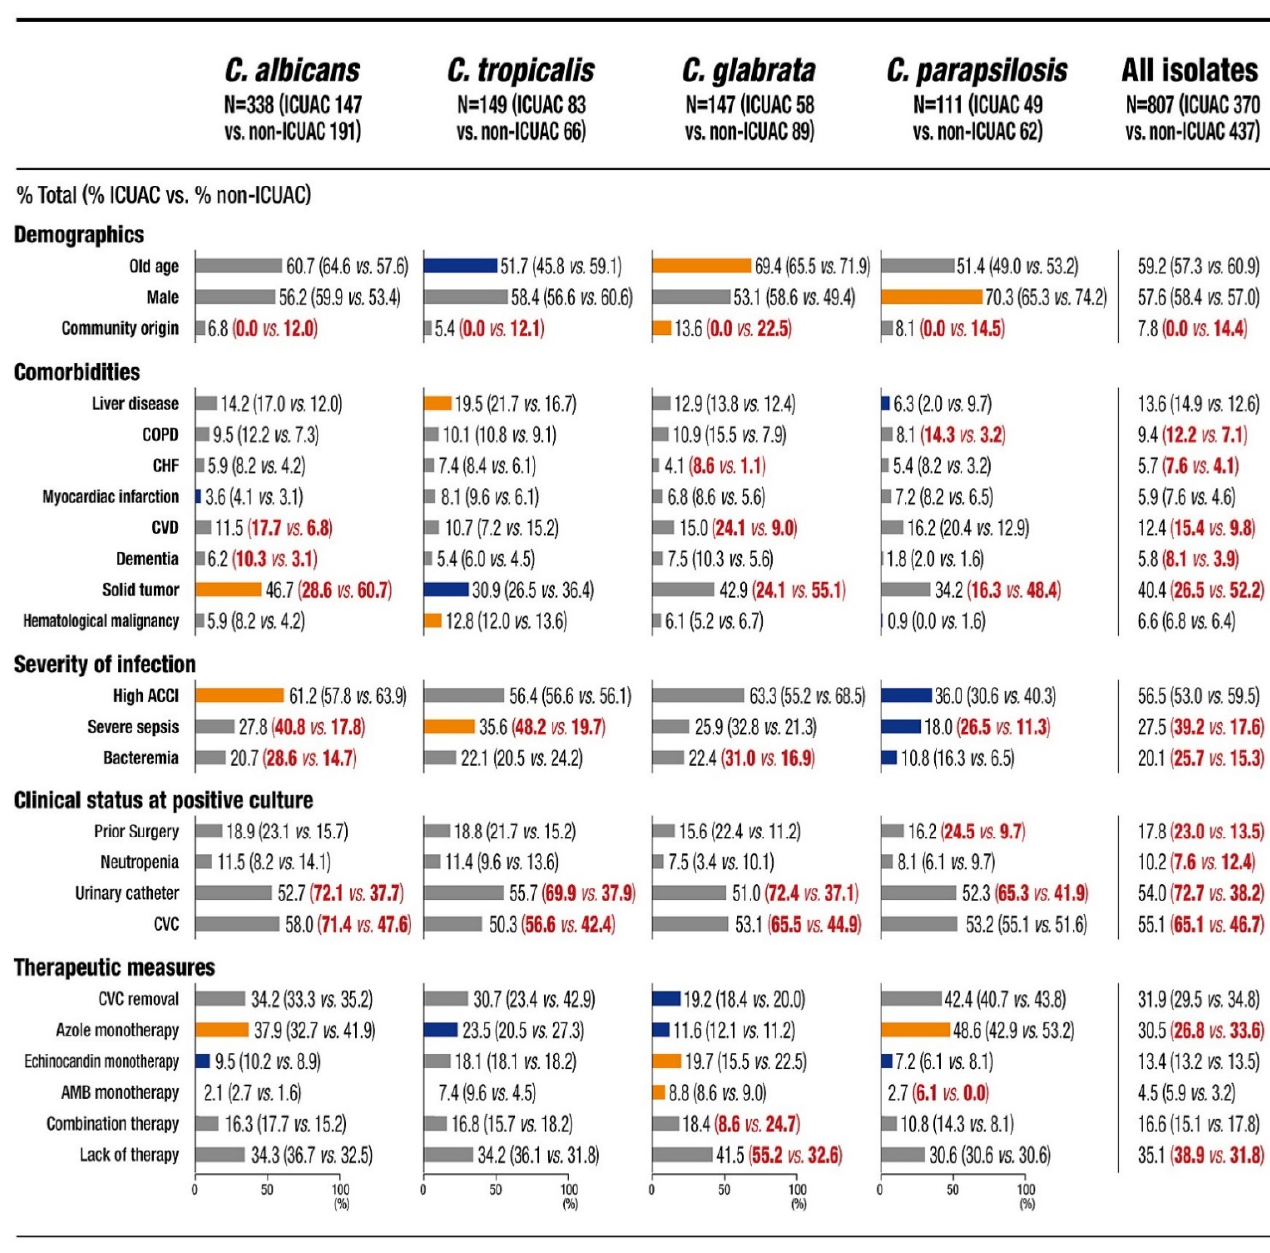
Figure 1. Baseline characteristics of the patients with intensive care unit-associated candidemia (ICUAC) versus non- ICUAC by Candida species and all species. The proportions of each variable (%) are indicated in the bar chart, and the statistical significance between a specific Candida species and all other Candida species within a given category ( p < 0.05) is represented by colored bars (orange, more frequent; blue, less frequent). The statistical significance ( p < 0.05) of each variable between ICUAC versus non-ICUAC within a given category is represented by red numbers. Abbreviations: COPD, chronic obstructive pulmonary disease; CHF, congestive heart failure; CVD, cerebrovascular disease; ACCI, age-adjusted Charlson comorbidity index; CVC, central venous catheter; AMB, amphotericin B.